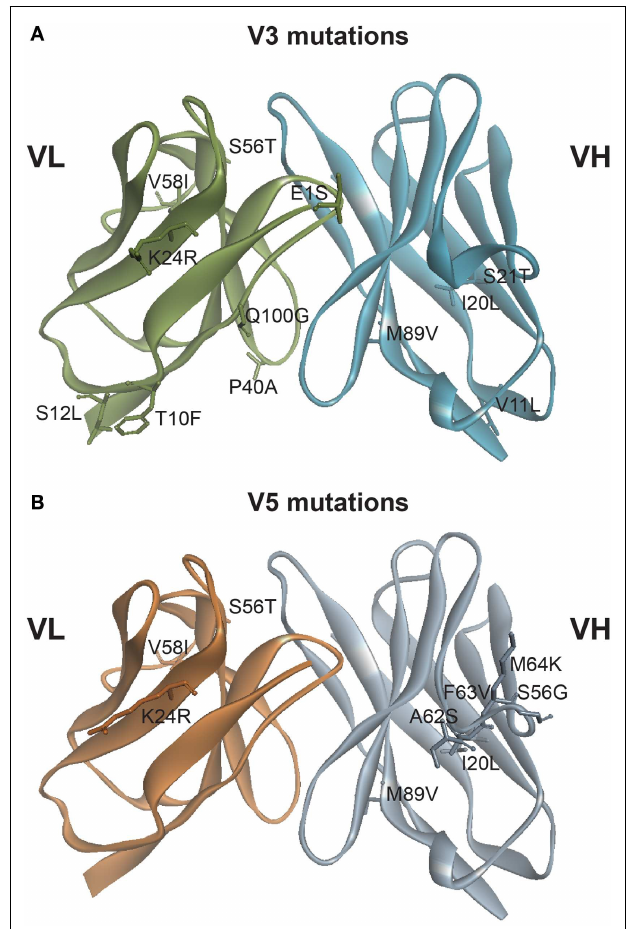
FIGURE 1 | Mutations generated based on in silico modeling . (A) Location of 12 point mutations in hu3F8 for constructV3. (B) Location of nine point mutations in hu3F8 for constructV5. Full listing of mutational energies can be found in Tables 1 and 2